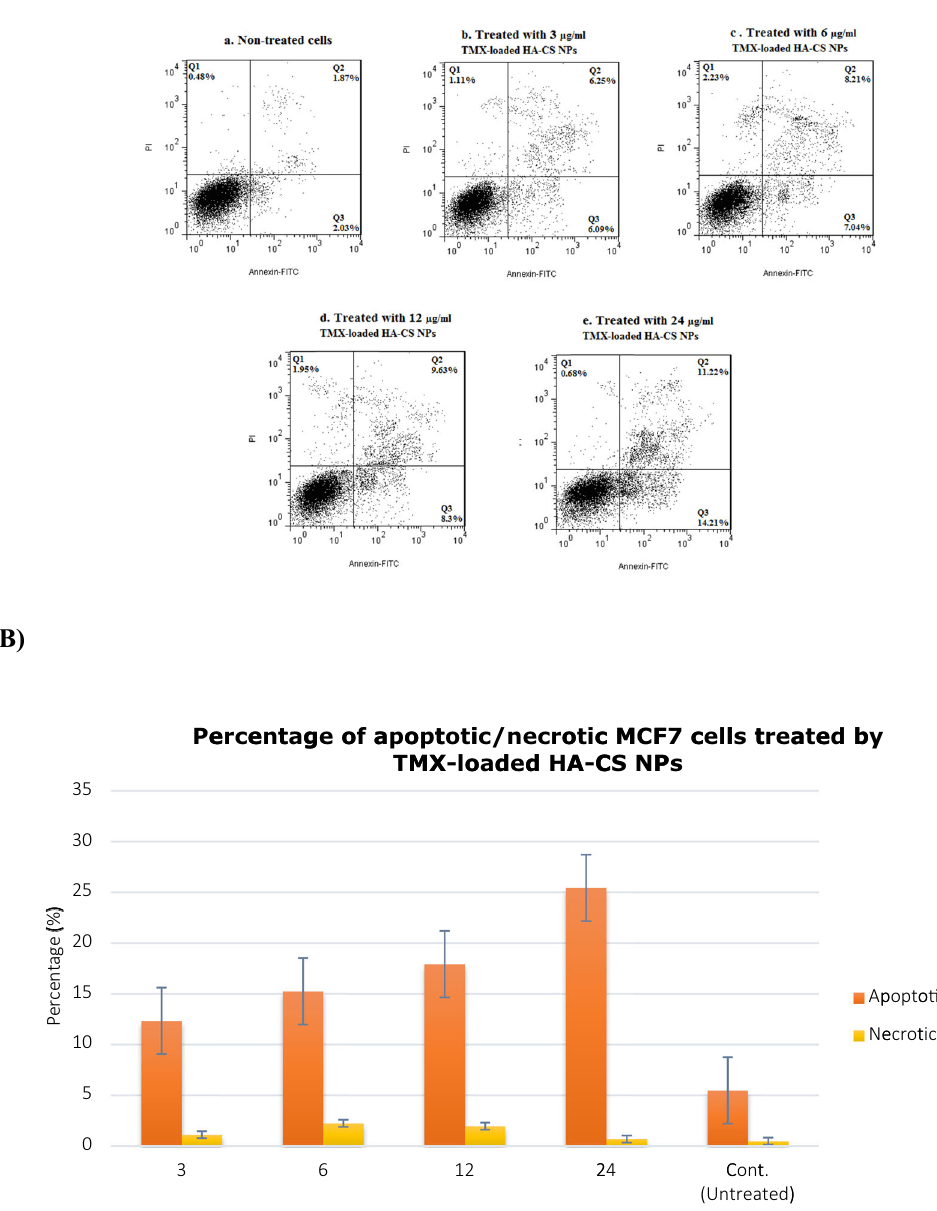
Fig. 5 Contour diagram of annexin V/PI fl ow cytometry. A MCF7 cells treated with different concentrations of the TMX (3, 6, 12, & 24 µg/ml) in HA-CS NPs. (a) Untreated cells, (b) MCF7 cells treated with 3 µg/ml TMX loaded in HA-CS NPs, (c) MCF7 cells treated with 6 µg/ml TMX loaded in HA-CS NPs, (d) MCF7 cells treated with 12 µg/ml TMX loaded in HA-CS NPs, (e) MCF7cells treated with 24 µg/ml TMX loaded in HA-CS NPs. Lower left quadrants show viable cells. The upper left quadrants contain the nonviable, necrotic